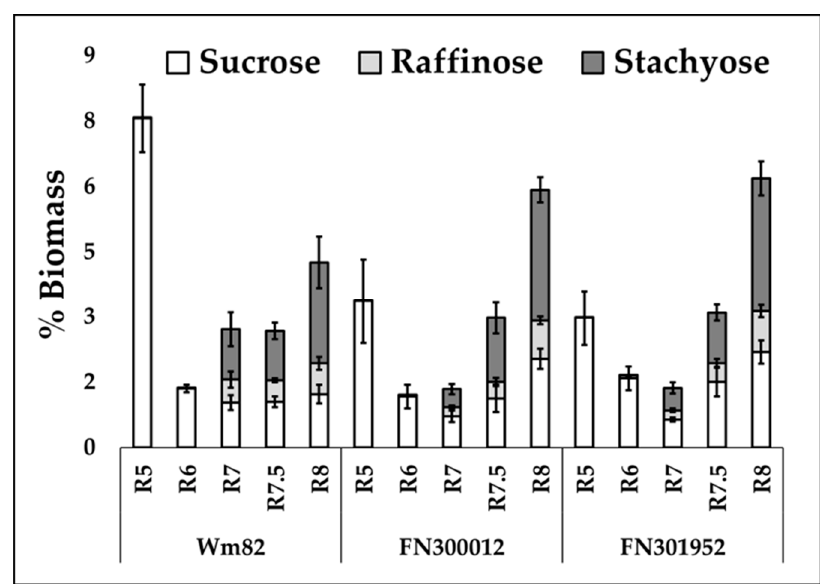
Figure 4. Sucrose, raffinose, and stachyose content in the two lines, FN300012 and FN301952, compared to Williams 82 over the course of development. Error bars represent standard error of the mean ( n = 6). Absolute values are presented in Table S3.